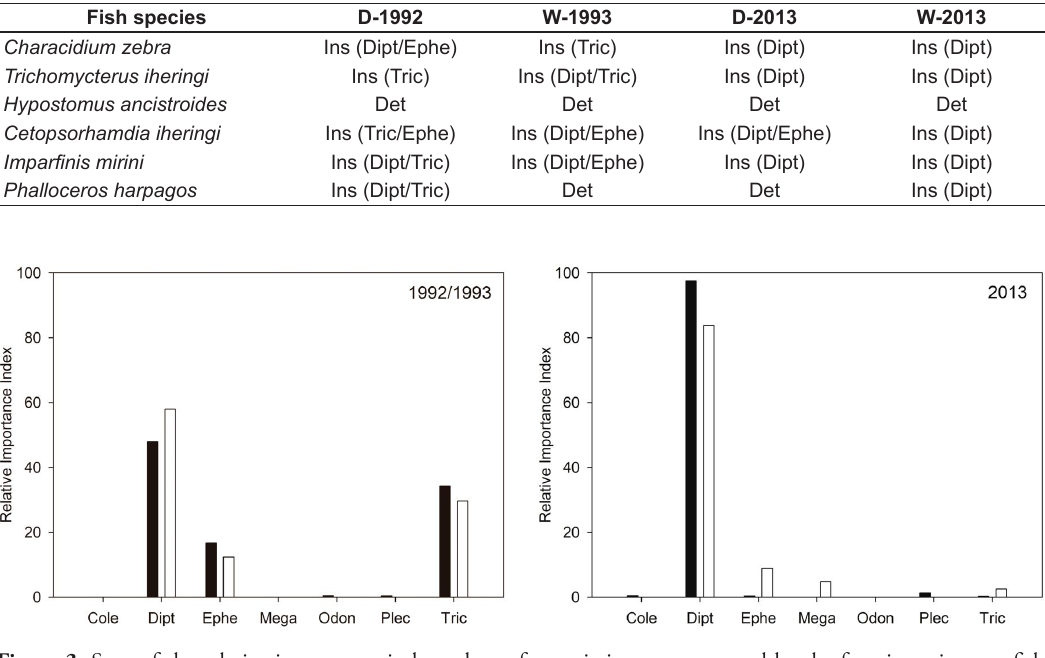
Figure 3. Sum of the relative importance index values of aquatic insects consumed by the four insectivorous fish species sampled in 1992/1993 and 2013 in Capivara River. Black bars represent the wet and white bars the dry season. Insect orders: Cole-Coleoptera, Dipt-Diptera, Ephe-Ephemeroptera, Mega-Megaloptera, Odon-Odonata, Plec-Plecoptera, Tric-Trichoptera.